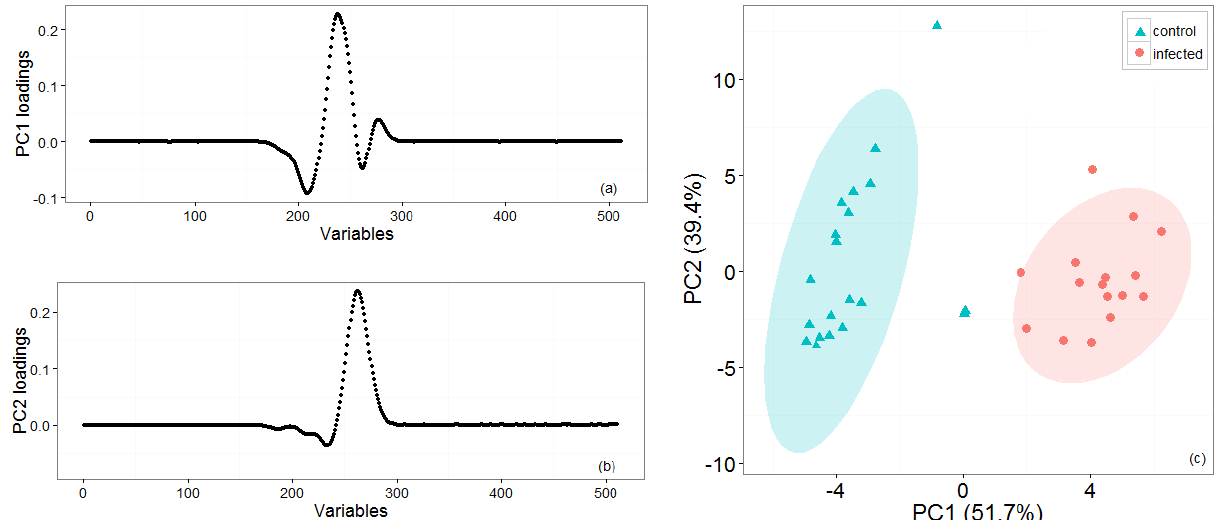
Figure 3. First set of experiments: Loading plots ( a , b ) for the two first principal components that account for most of the variance. ( c ) PCA and k-means clustering for two groups of potato tubers, with controls (cyan triangles) and infected (red circles) which have been grouped with 95% confidence ellipses around the centroid identified by the k-means algorithm.